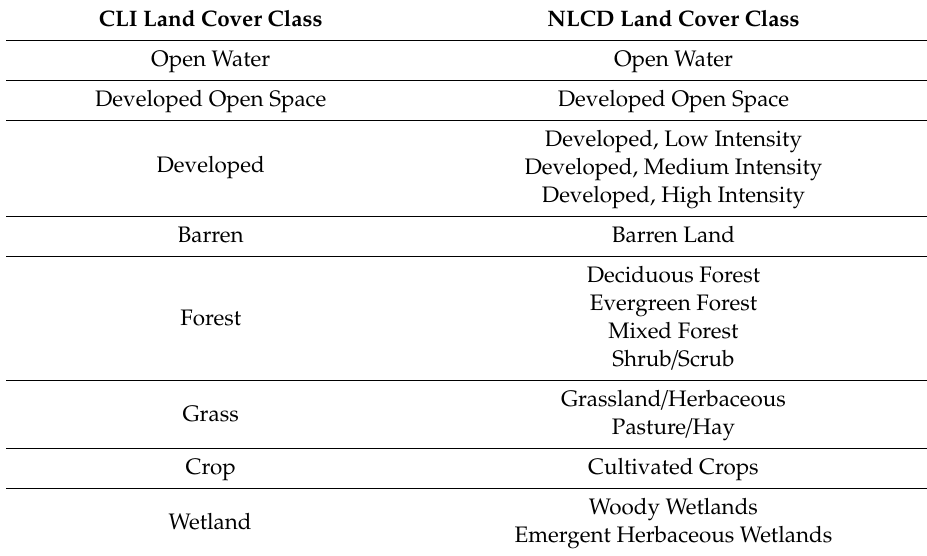
Table A1. Reclassification scheme for National Land Cover Database (NLCD) land cover classes to the Changing Landscapes Initiative (CLI) study area classification in norther